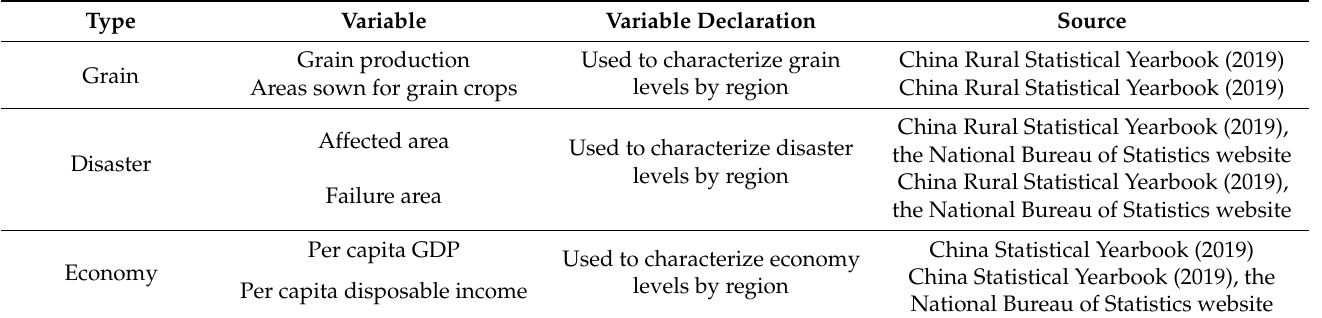
Table 1. The summary table of the data relating to the gravity model.